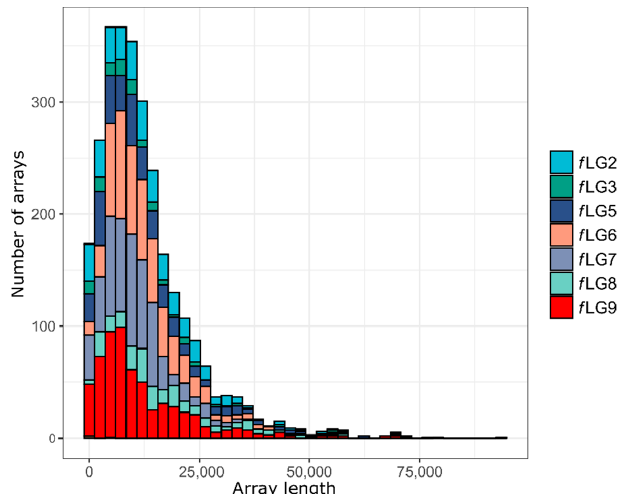
Figure 7. Distribution histogram of TFREE satellite DNA arrays in the T. freemani genome assembly Tfree1.0. Total of 2766 arrays of the TFREE satellite DNA in the assembled T. freemani genome are shown as they exceeded the defined stretch of five consecutive monomers used as a tandem organization criterion (Table S7). TFREE arrays have not been successfully assembled for three linkage groups ( f LG4, f LG10, and f LGX) and thus are not visualized on the plot.